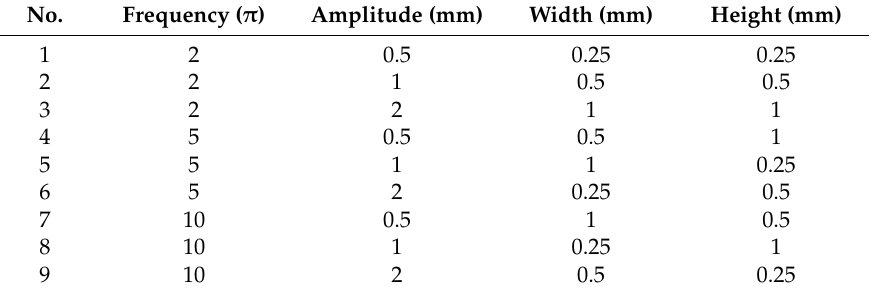
Table 1. Orthogonal array for L 9 with four parameters and three level